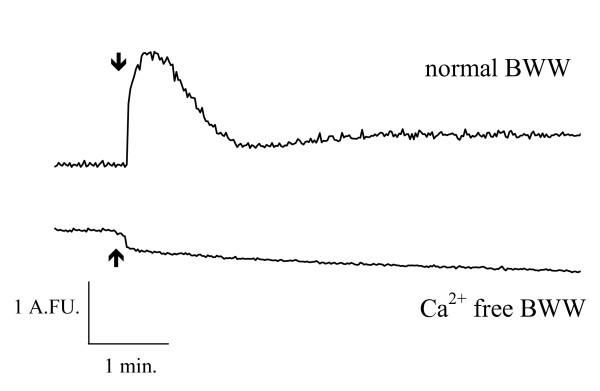
Effect of extracellular Ca2+ depletion on the human zona pellucida-induced intracellular [Ca2+] increase in spermatozoa. Capacitated, Fura-2-loaded spermatozoa were incubated in normal BWW medium (upper curve) or in BWW medium lacking calcium (lower curve). One minute before adding hZP, EGTA (500 μM) was added to the Ca2+ free BWW, to ensure that the extracellular medium was devoid of Ca2+. Solubilised hZP (2/μl) was added (arrow) to the medium for each incubation. Results are expressed as the fluorescence excitation ratio (340/380 excitation wavelengths, in arbitrary fluorescence units (AFU)) as a function of time (min). A typical experiment is shown.